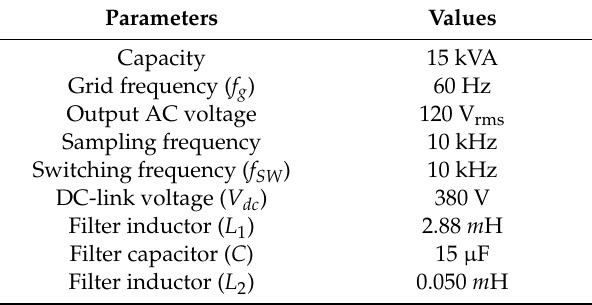
Table 1. Nominal Parameters of the